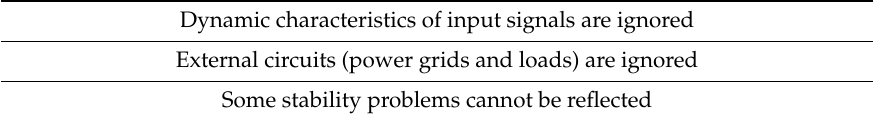
Figure 6. Simulated waveform of grid current under different conditions (repeated simulation of [22]). As a summary, we list the flaws of the conventional model of a shunt APF in Table 2. Table 2. Flaws of the conventional model of a shunt APF.